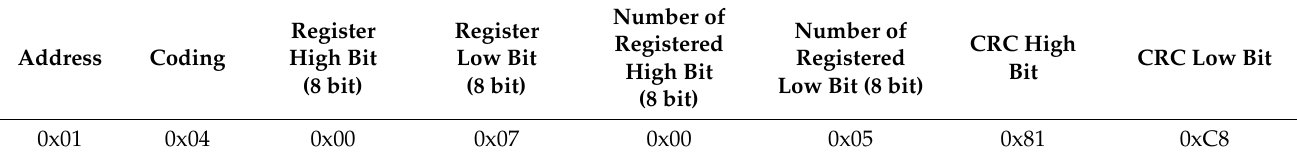
Figure A2. Tests of command sending from RX64M to Sensor. Table A1. The requirements format sending from Host (RX64M).